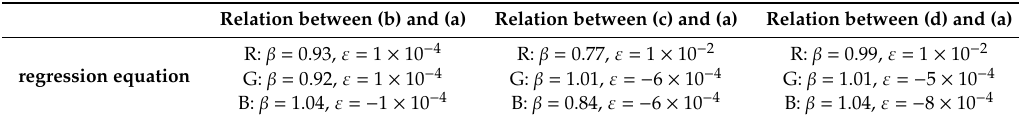
Table 1. Comparisons between four conditions. (a), (b), (c), and (d) are the four conditions explained in Figure 3. R, G, and B represent the fitting of red, green and blue color parameters, respectively. β and ε represent the slope and intercept of the regression equation fitted by two cases, respectively.